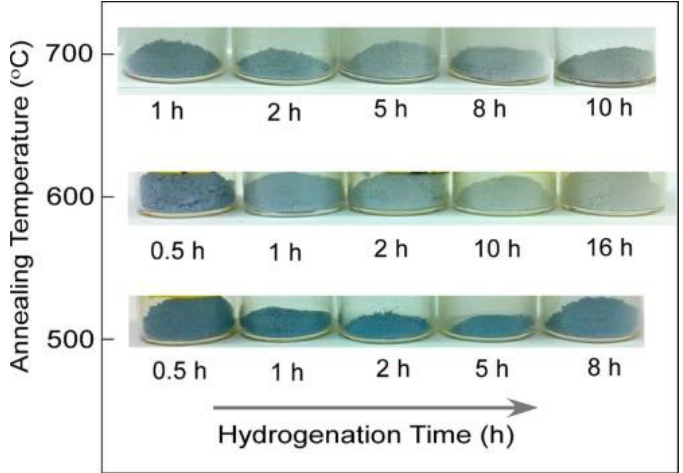
Figure 3. The color changes of hydrogenated titania samples prepared with H 2 gas flow at tempera- tures 500–700 ◦ C. Reprinted with permission from [95]. Copyright 2013, American Chemical Society.